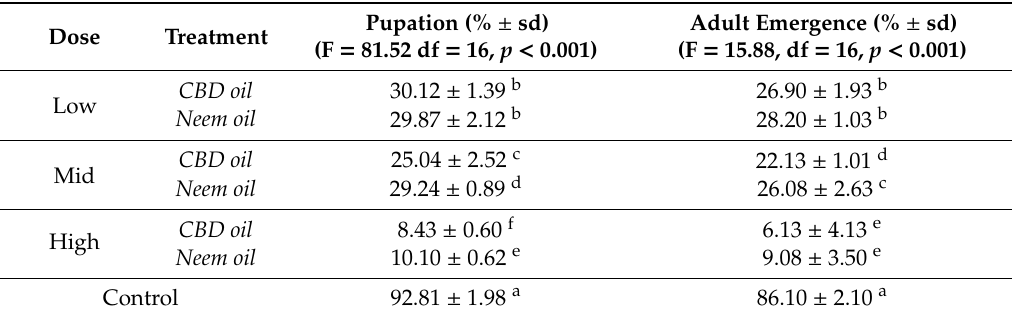
Table 4. Mean e ff ect of CBD oil and neem oil on pupation and adult emergence (% ± sd) of 4th larval instars of P. interpunctella. Means of the same column followed by the same letter are not significantly di ff erent (Long Rank test, p = 0.05).